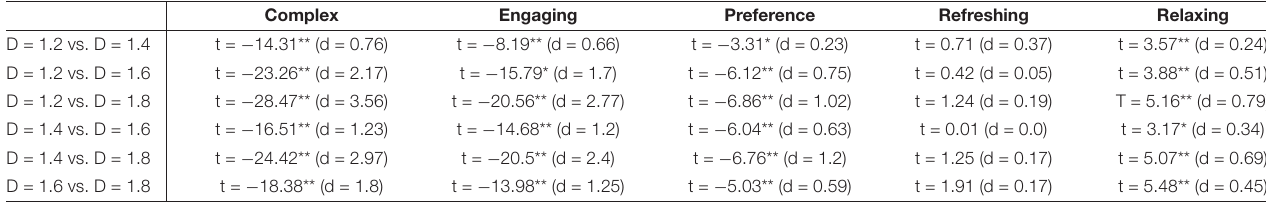
TABLE 1 | Experiment 1A-paired samples t -tests across D -value and judgment. Complex Engaging Preference